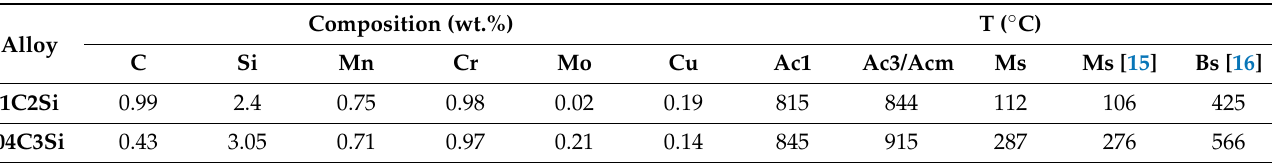
Table 1. Chemical composition of the steels and experimental critical temperatures obtained from dilatometric curves as described in the main body of the text. Theoretical Ms and Bs calculated according to provided references. Composition (wt.%) T ( ◦ Alloy